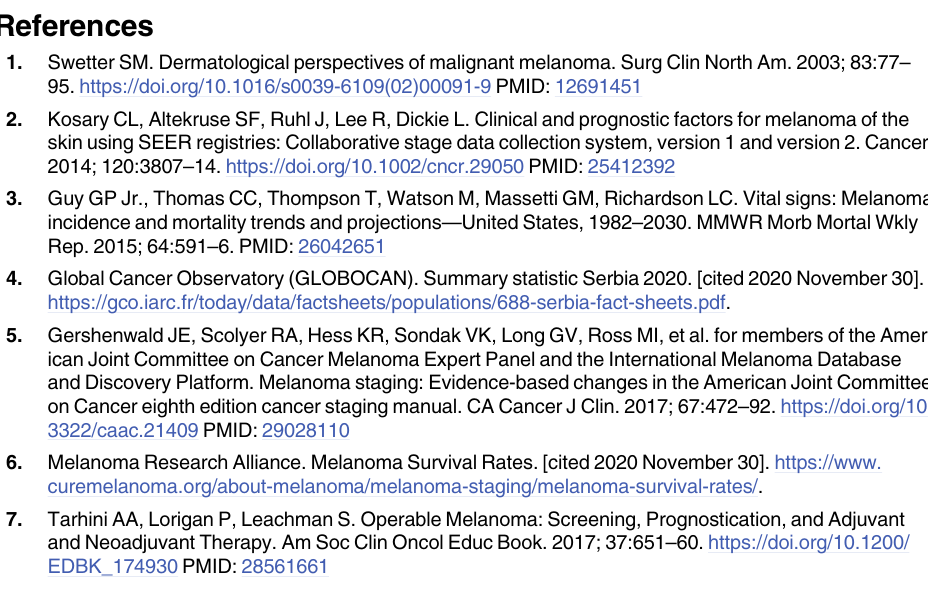
S2 Table. Correlations of FACT-M domain scores with SF-36 questionnaire